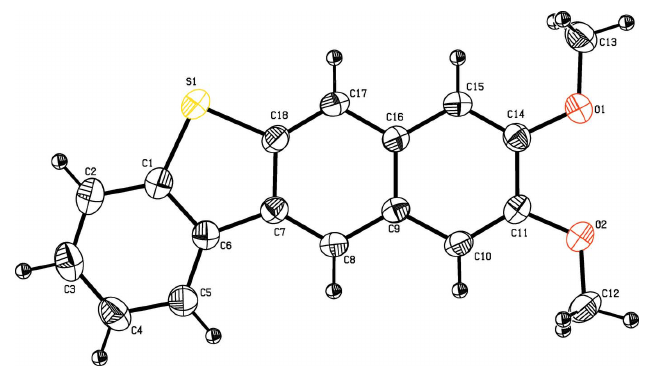
Figure 1 The molecular structure of the title compound, with displacement ellipsoids drawn at the 50% probability